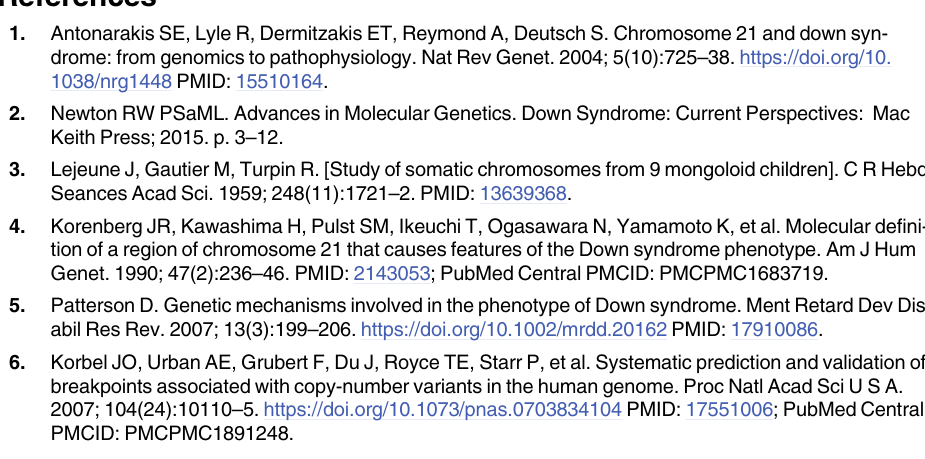
S1 Fig. Data quality control. (a) Density plot raw and normalized (Quantile) data; (b) Plot principal component analysis (PCA), component 1 (20.2%) vs. component 2 (18.8%); compo- nent 3 (7.8%) and component 4 (6.3) are not shown. Colour annotation represents cases (red: Down syndrome) and controls (black healthy controls). X and Y chromosomes were excluded from analysis.; (c) Plot principal component analysis (PCA), component 1 (20.2%) vs. compo- nent 2 (18.8%); component 3 (7.8%) and component 4 (6.3) are not shown. Colour annotation represents genders (red: male, black: female); D and N represent Down syndrome and healthy controls, respectively. X and Y chromosomes were excluded from